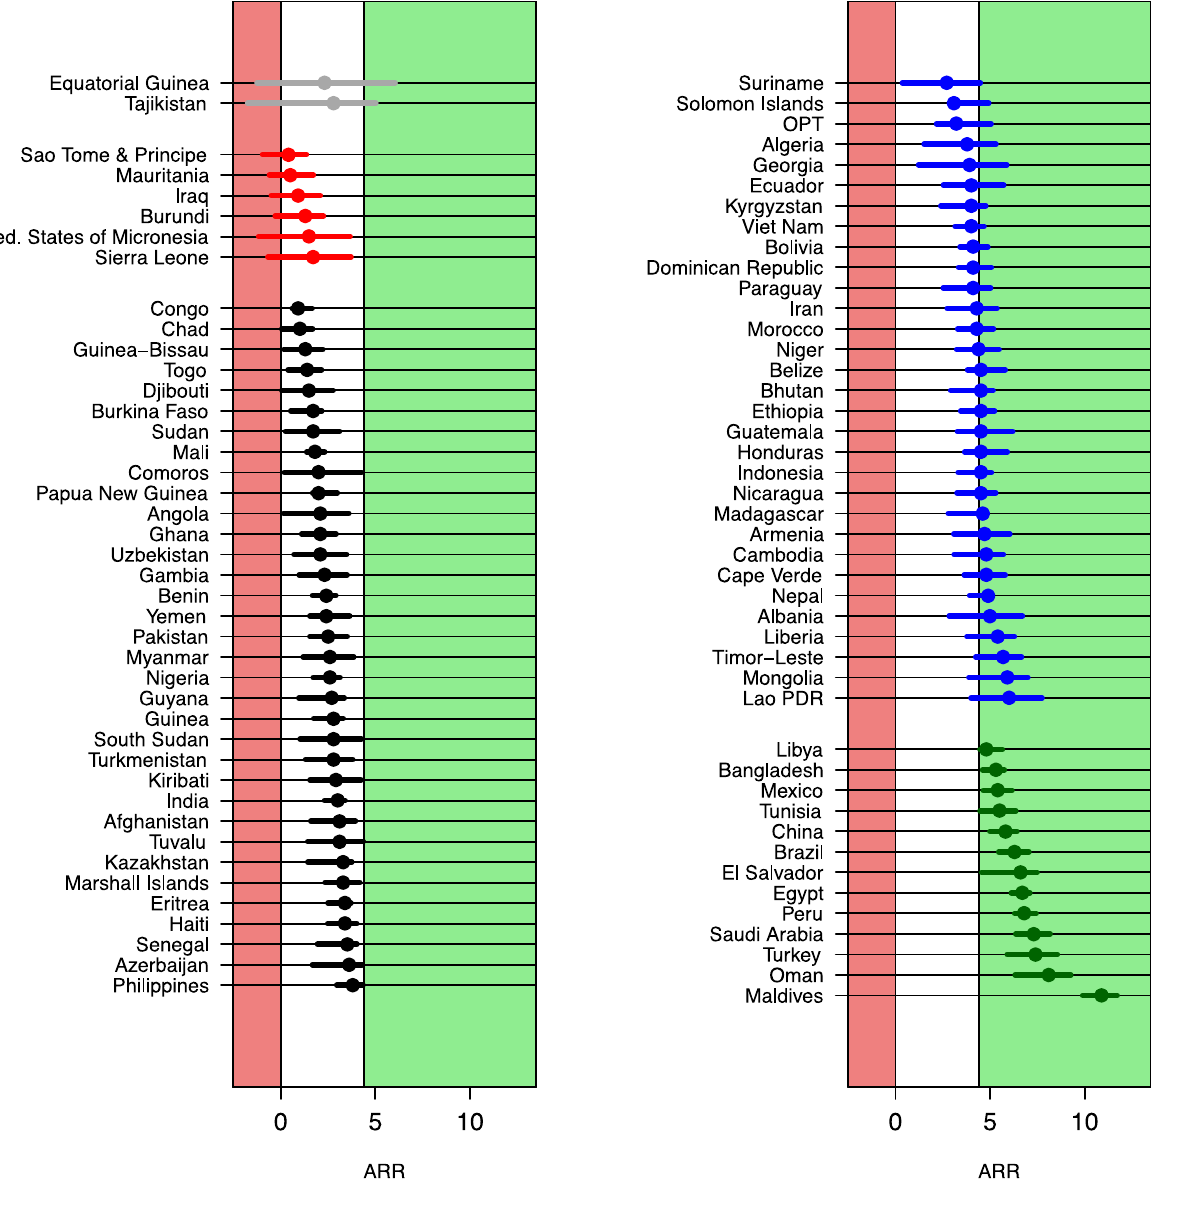
Figure 6. ARR from 1990 to 2011 for 86 high mortality countries. Countries are grouped based on the categories from Table 2 (lines colored grey, red, black, blue, and green for categories 1 to 5, respectively). Within each category, countries are sorted by the point estimate of the ARR. Lao PDR, Lao People’s Democratic Republic; OPT, Occupied Palestinian Territory.